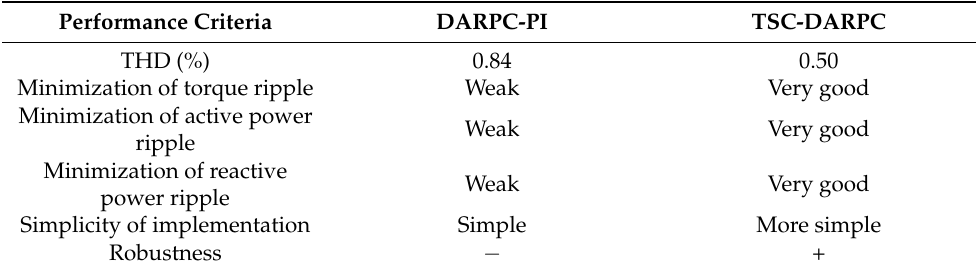
Table 2. Comparative study between DARPC-PI and TSC-DARPC. Performance